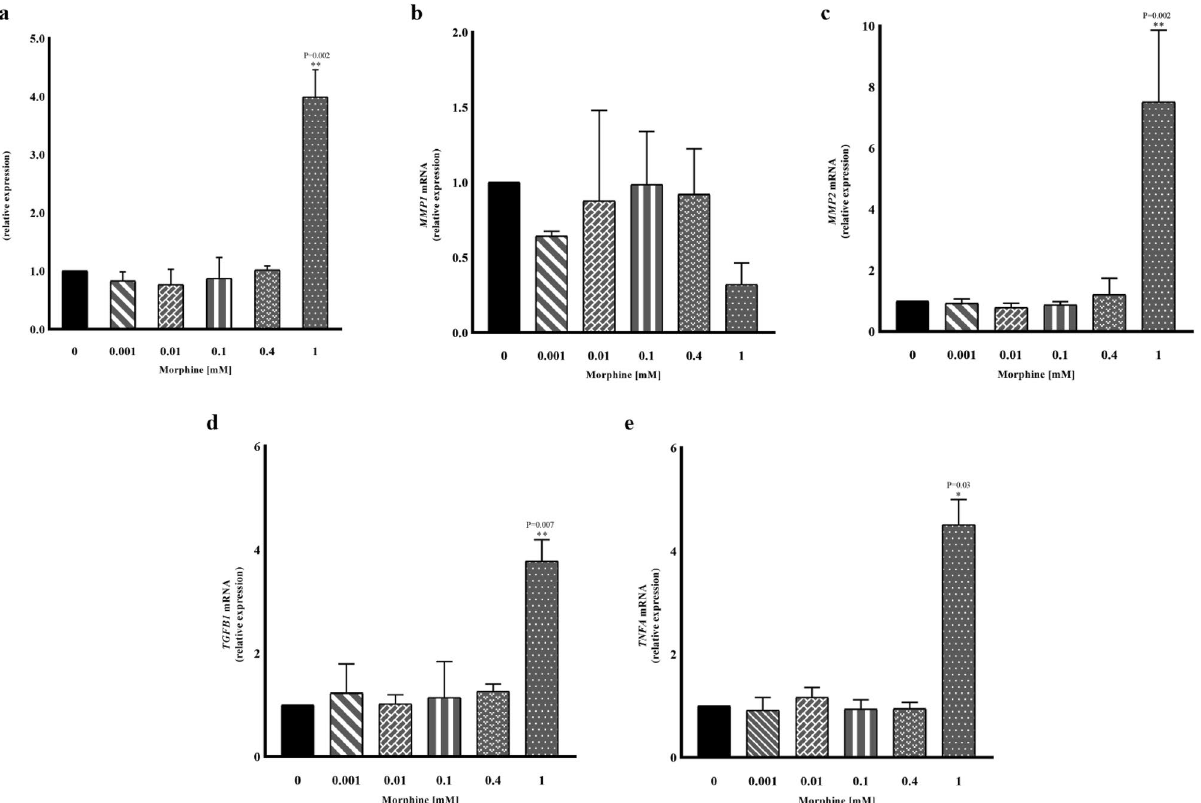
Figure 7. qRT – PCR evaluating the effect of different concentrations of morphine sulphate on COL1A1 , MMP1 , MMP2 , TGFB1 and TNFA gene expression, in human hMSCs exposed for eighteen days. The reported values are expressed as mean ± SD of three independent experiments and represented as fold changes compared to non-treated samples (0 mM). ( a ) 1 mM Morphine sulphate induces a fourfold increase of COL1A1 mRNA levels. ( b ) 1 mM morphine treatment induced a 0.5 fold downregulation although not statistically significant of mRNA MMP1 mRNA in hMSCs, and a sevenfold MMP2 gene upregulation ( c ). Eighteen days of 1 mM morphine sulphate exposition displayed fourfold expression increase of both TGFB1 ( d ) and TNFA ( e